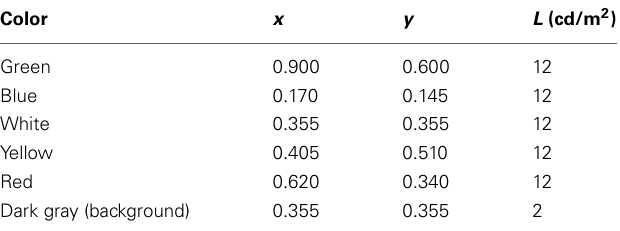
Table 1 | CIE 1931 coordinates of the stimulus colors.